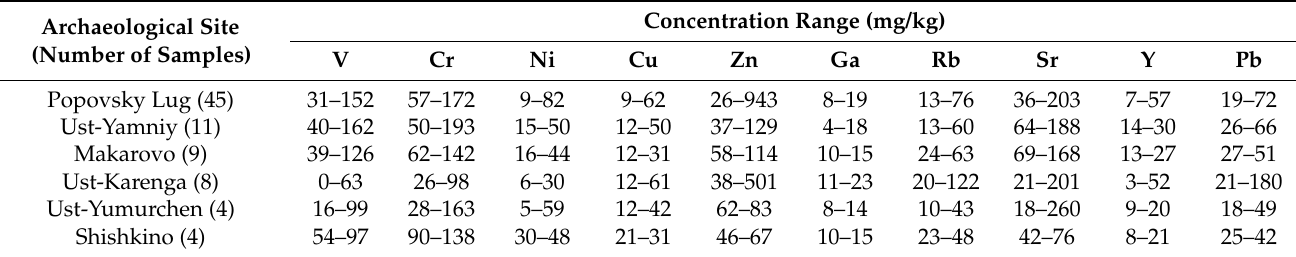
Table 1. Elemental characterization of ceramic samples by TXRF method.